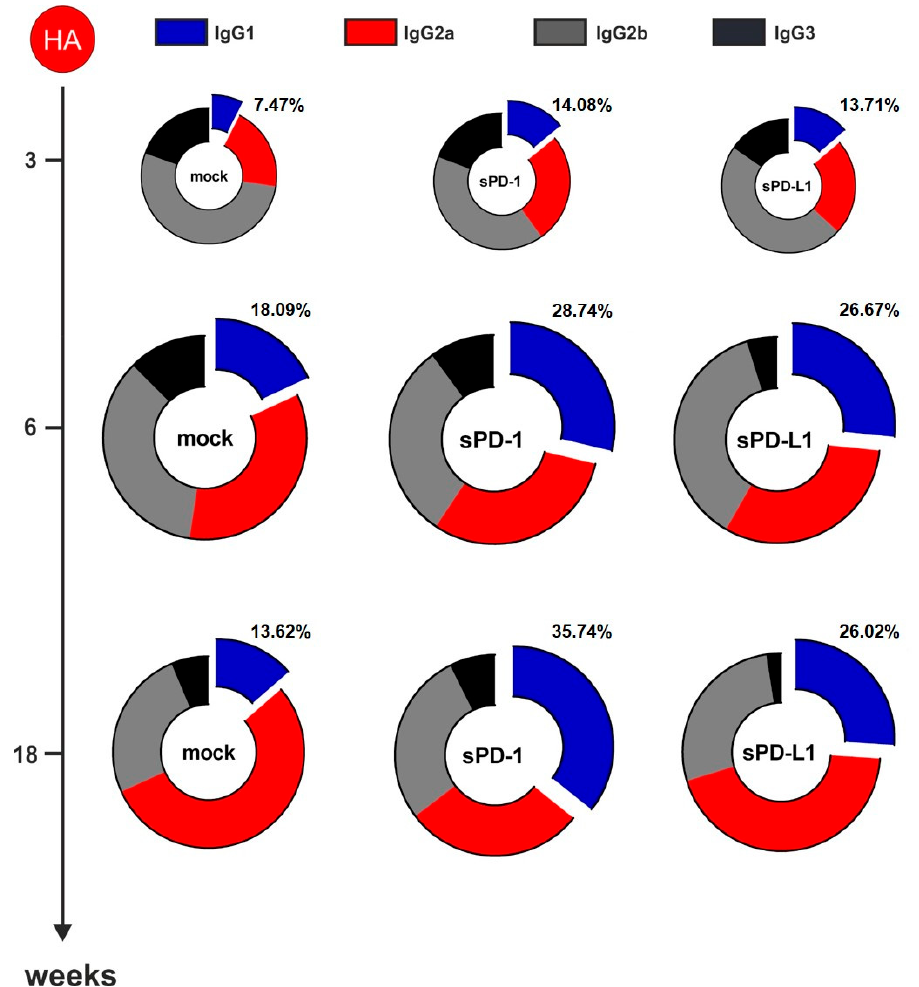
Figure 4. PD-1 co-expression results in a more balanced HA-specific antibody response. Antibody subtype patterns of HA-immunized mice three weeks after priming and two (week 6) and 14 weeks (week 18) after the booster immunization. The ring size represents the overall antibody response. Shown are mean percentages of 18 animals from three independent experiments. Each subtype was analyzed by ELISA with identical amounts of HRP-conjugated anti-mouse IgG1 (blue), IgG2a (red), IgG2b (gray), and IgG3 (black) antibodies.